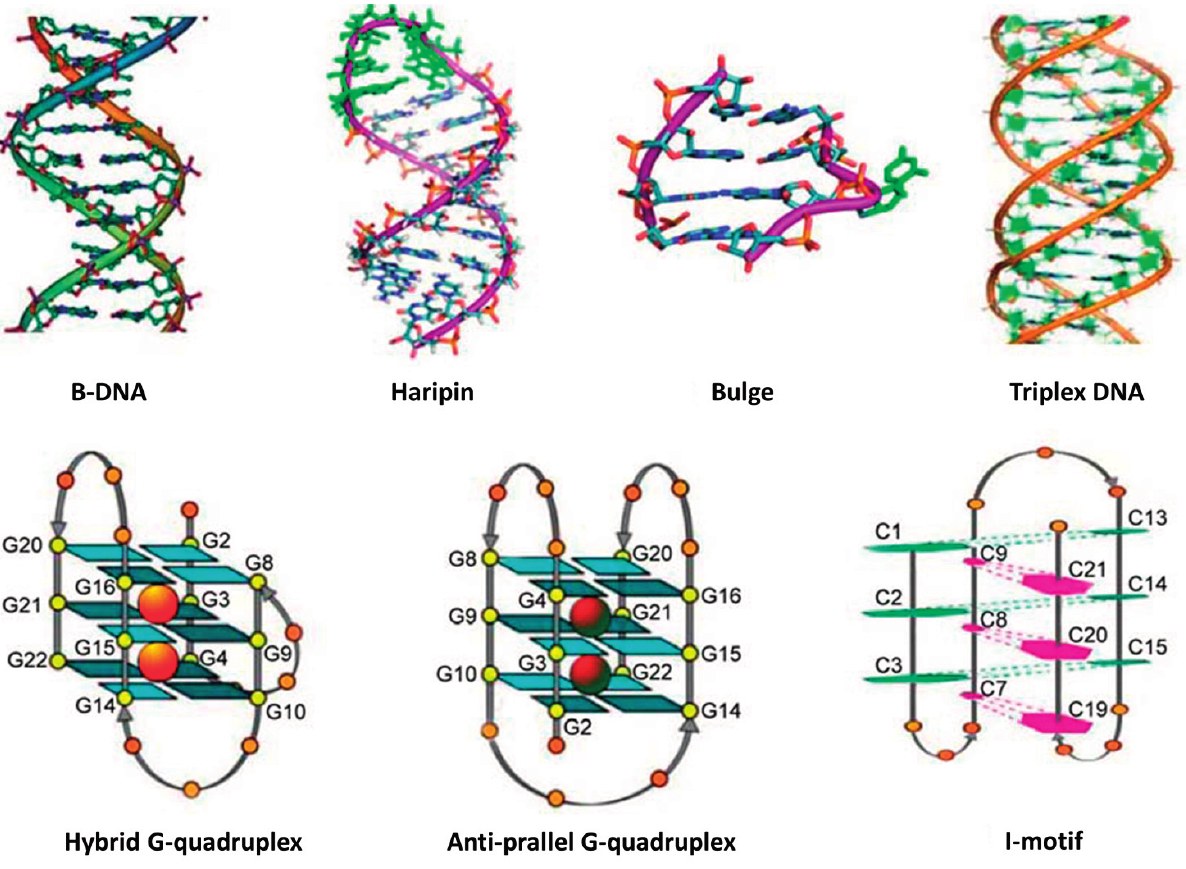
Figure 26. Selected secondary structures of DNA. Reprinted with permission from ref. [263], copyright (2014) Science China